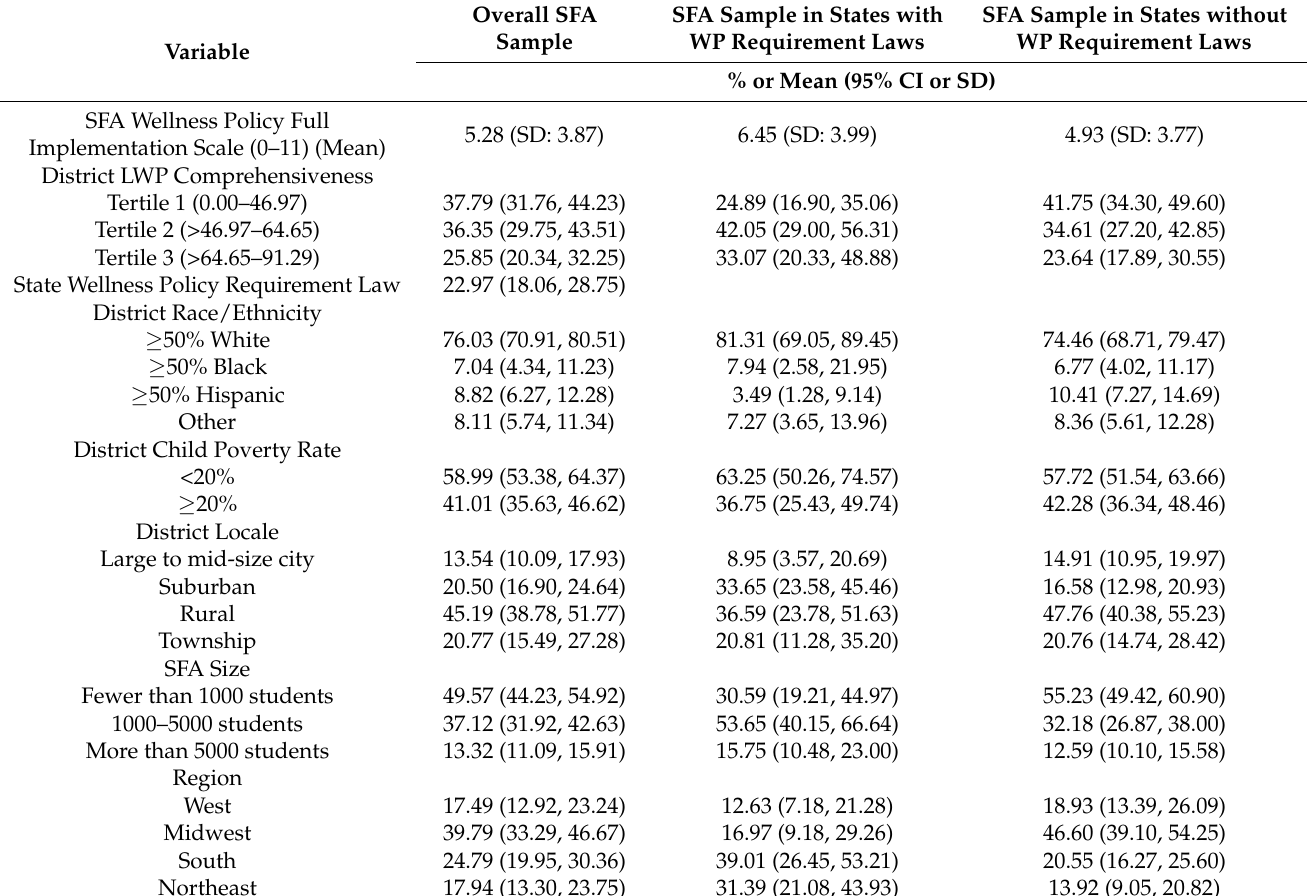
Table 1. School food authority survey—weighted sample